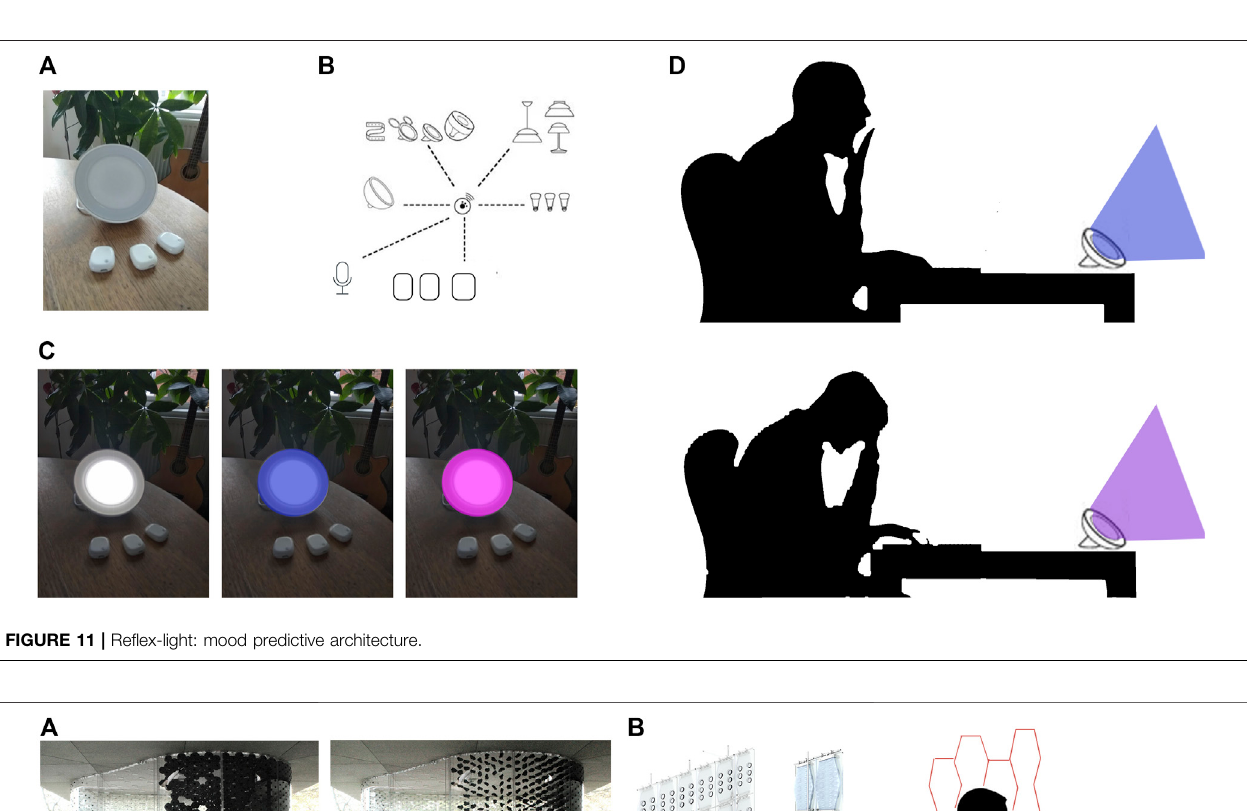
FIGURE 10 | Flex-seat: a sensing adaptive kinetic chair (concept) for posture management. Image source for (A) : https://www.behance.net/gallery/16827089/ Parametric-Waf fl e-Bench.